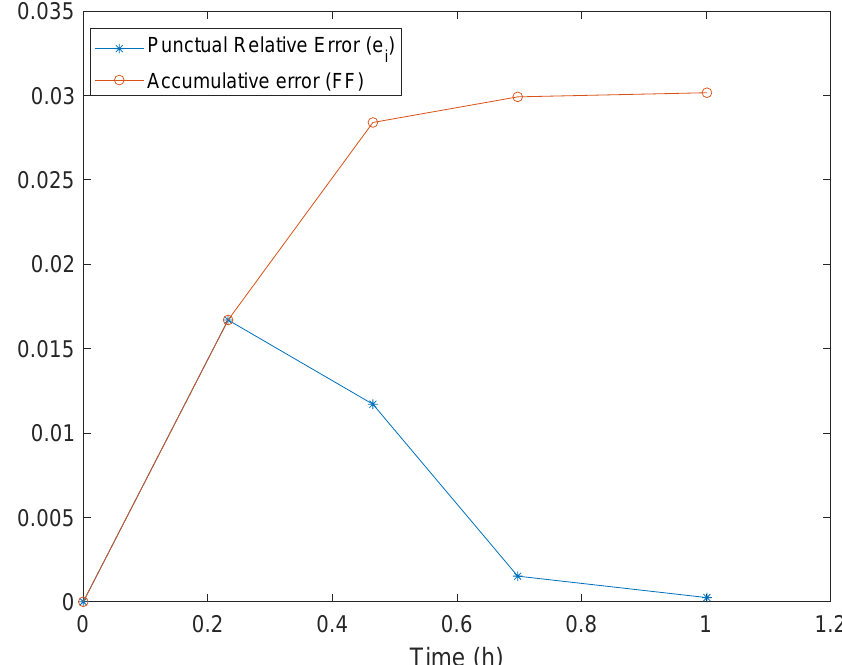
Figure 3. Punctual and accumulative errors e i and FF that are defined by (22) and (21), respectively, at the time instants t ∈ T = { 0,0.2325,0.4652,0.6975,1.014 } , measured in hours.